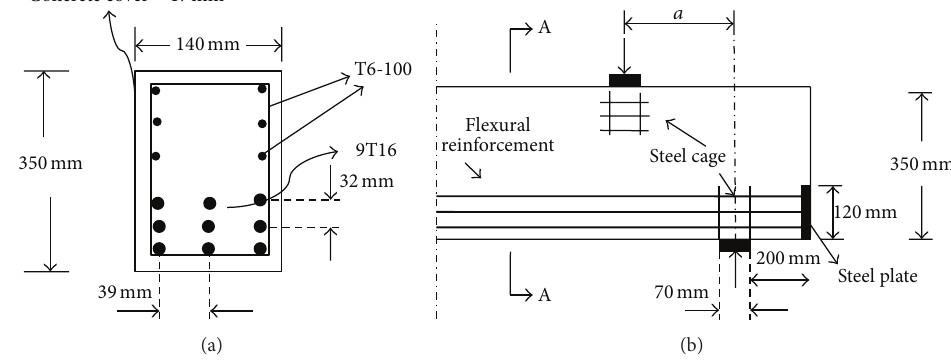
Figure 2: Beam details for half length: (a) section A-A, (b) side view.